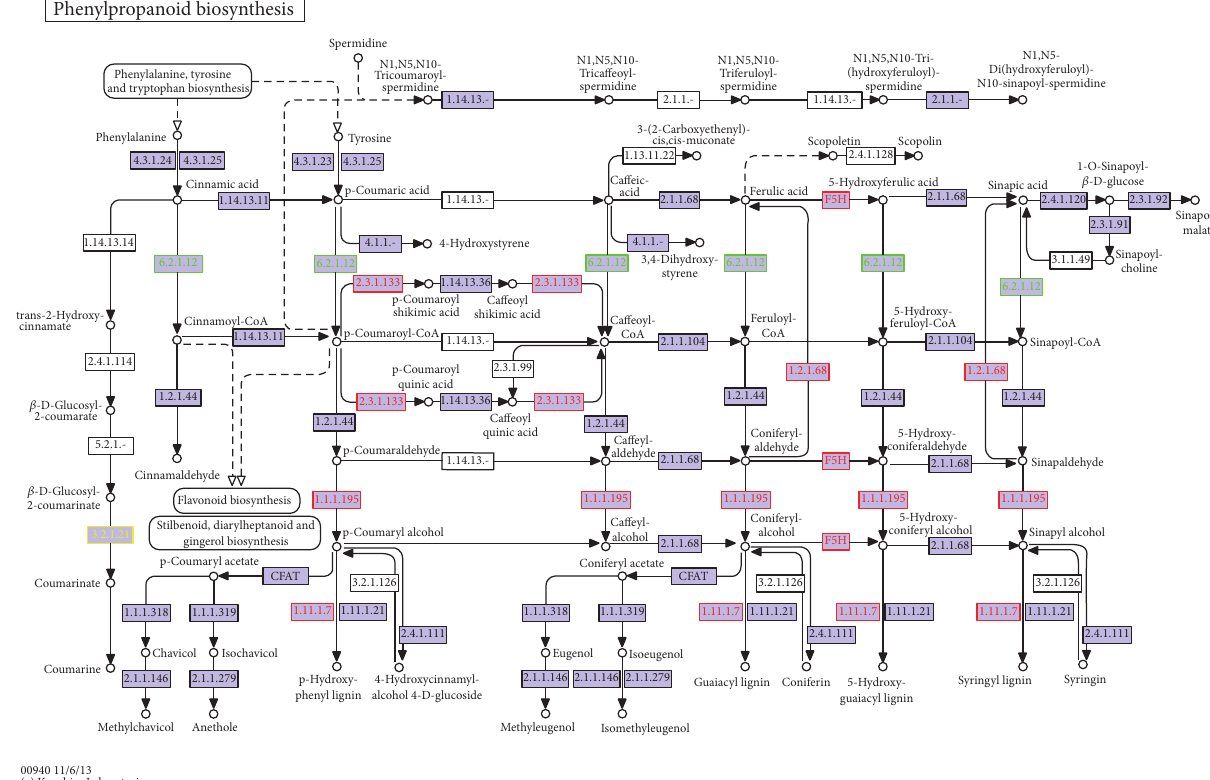
Figure 5: Representation of genes related to phenolic acid biosynthesis. Note: the red frames and red letters or numbers represent upregulated DEGs in BH18; the green frames and green letters or numbers represent downregulated DEGs in BH18; the purple frames represent non-